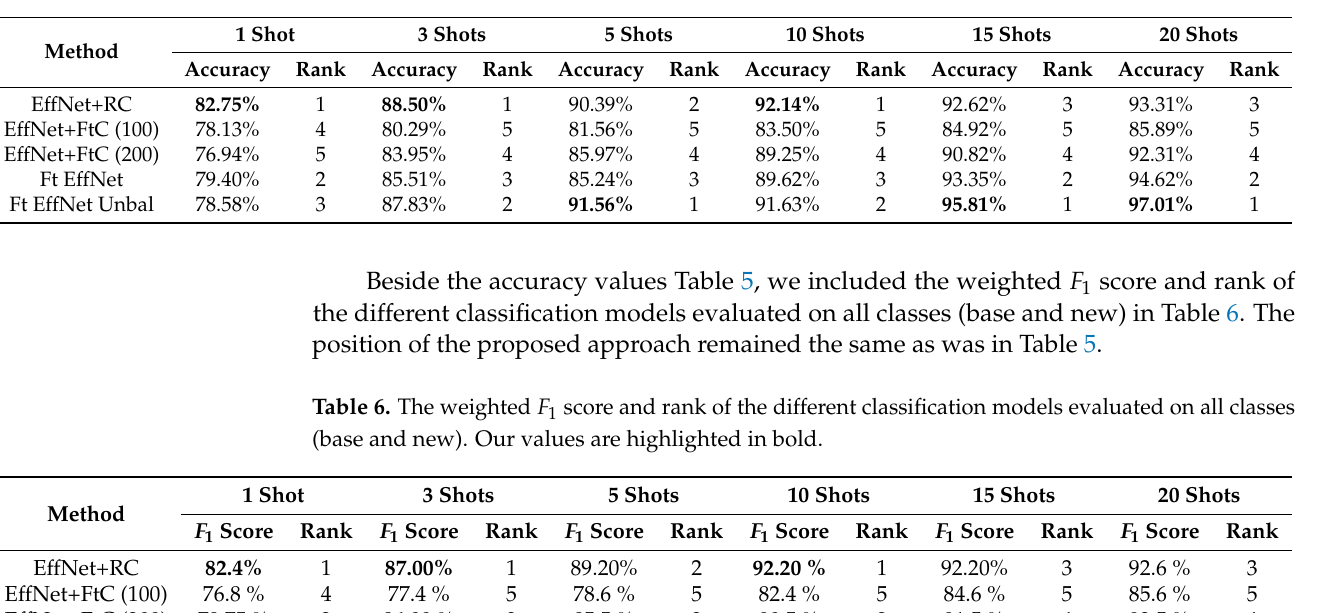
Table 5. The accuracy and rank of the different classification models evaluated on all classes (base and new). Our values are highlighted in bold.